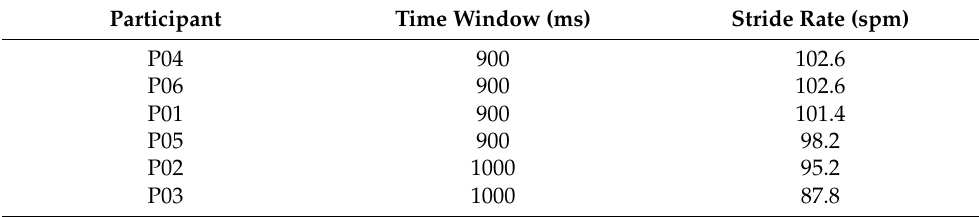
Figure 10. Acceleration resultant signal of the IMU during three steps. Blue shadowed rectangles visualize the stance phase. Green shadowed rectangles illustrate the swing phase. Red transparent rectangles represent the maximum time window for the TO detection. Red shadowed rectangles illustrate the tolerance for the end of the time window. Table 1. Participants’ stride rates (in steps per minute: spm) and their adapted time windows (in milliseconds: ms) for the gait event detection at the IMU in the validation